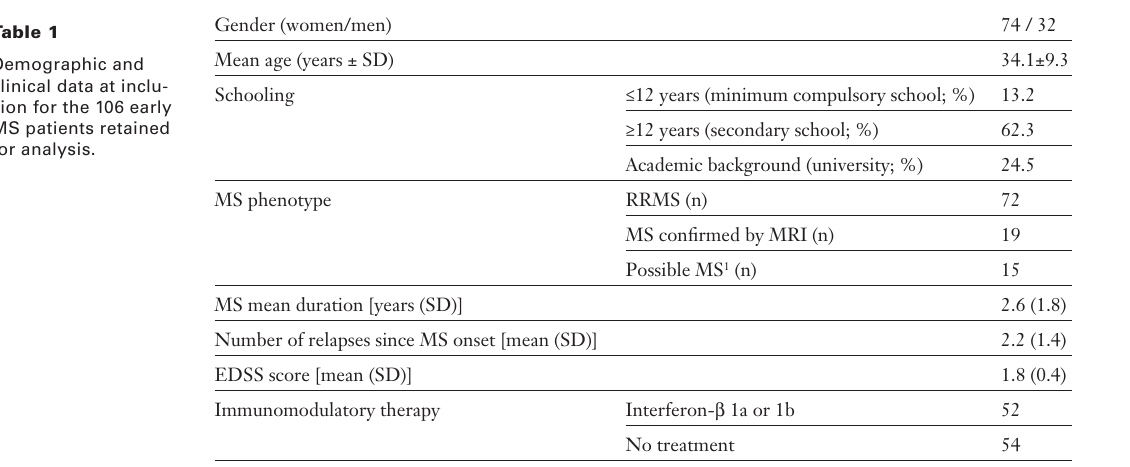
Table 1 Demographic and clinical data at inclu- sion for the 106 early MS patients retained for analysis.